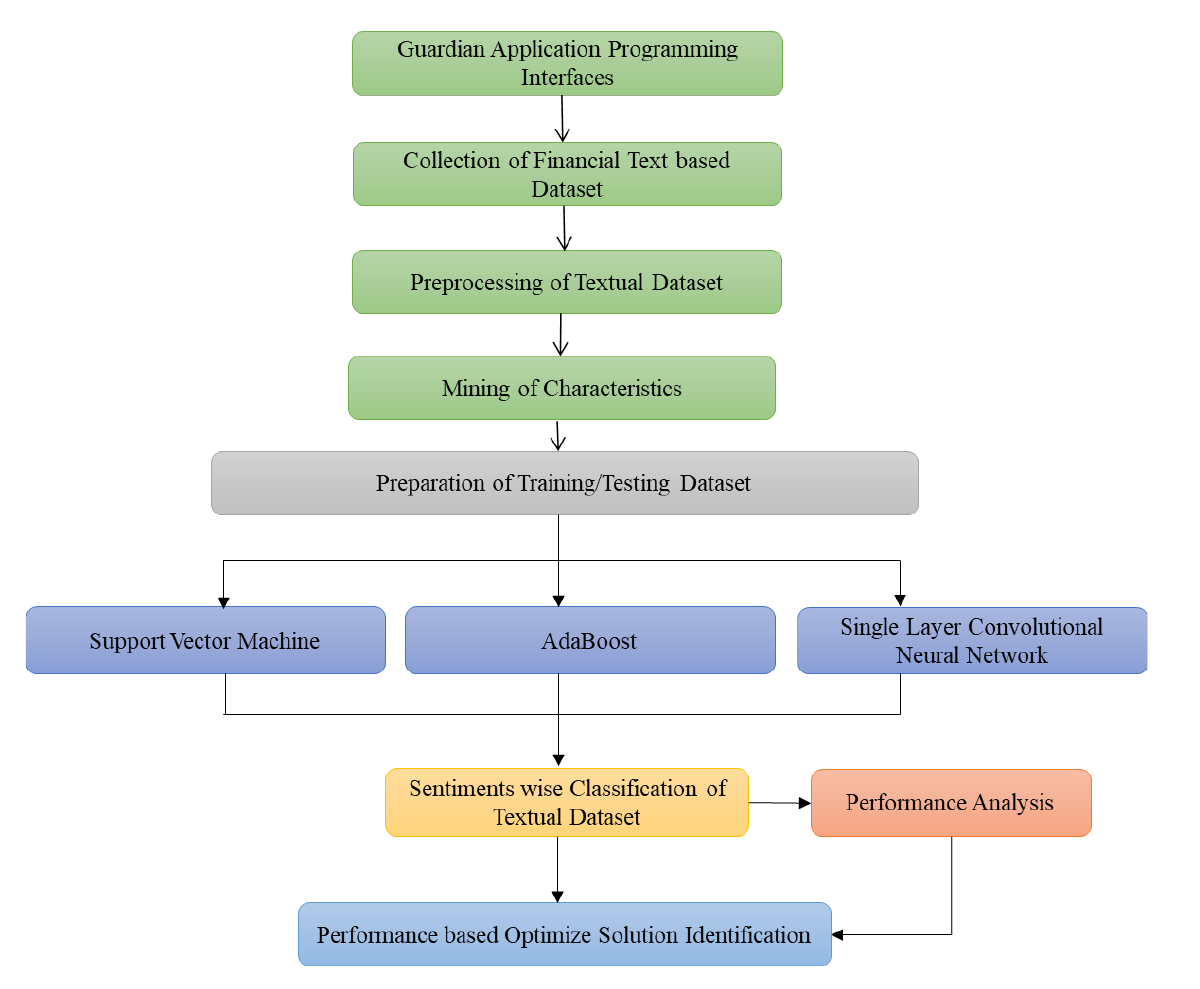
Figure 4. Process for Text-Based Sentimental Classification.